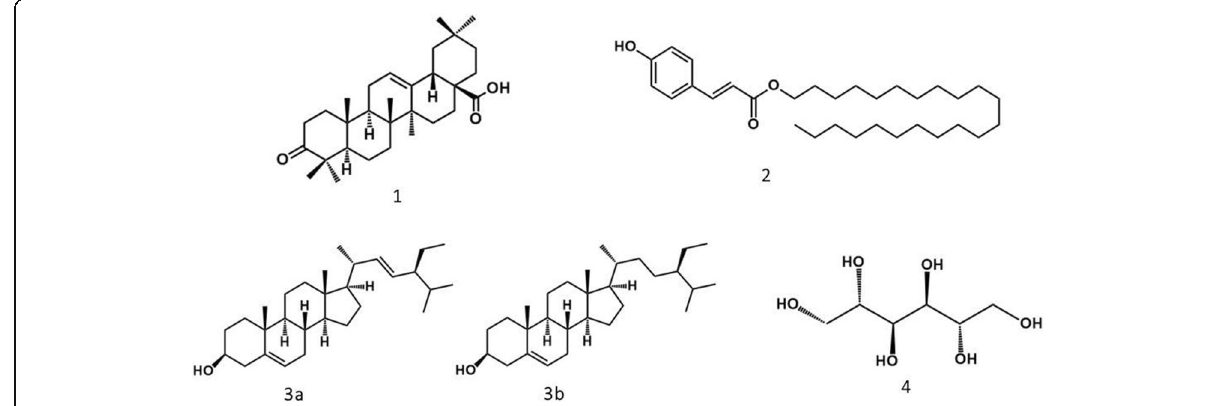
Fig. 1 Isolated compounds from the stem bark of Aidia